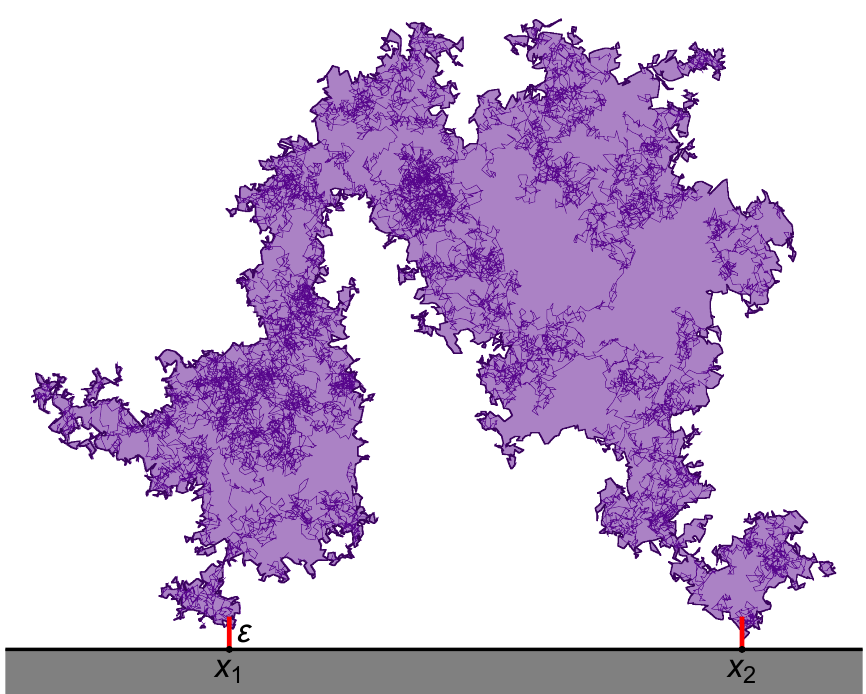
Figure 3 . A Brownian loop and its outer boundary in the upper-half plane. Such a loop would contribute to the two-point function of boundary edge counting operators inserted at x because the loop intersects the slits of size ε at both